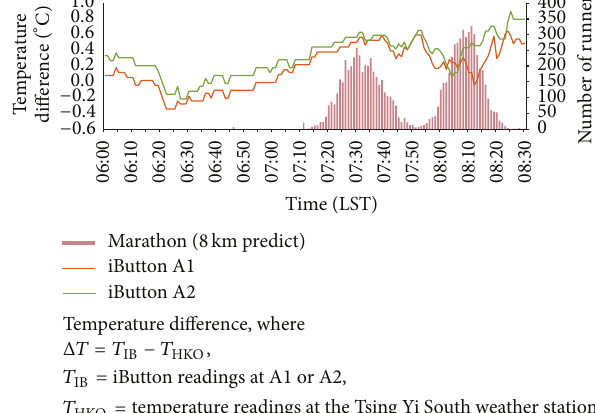
Figure 4: Minute-by-minute temperature difference and runner counts at the Stonecutters Bridge (Site A: open